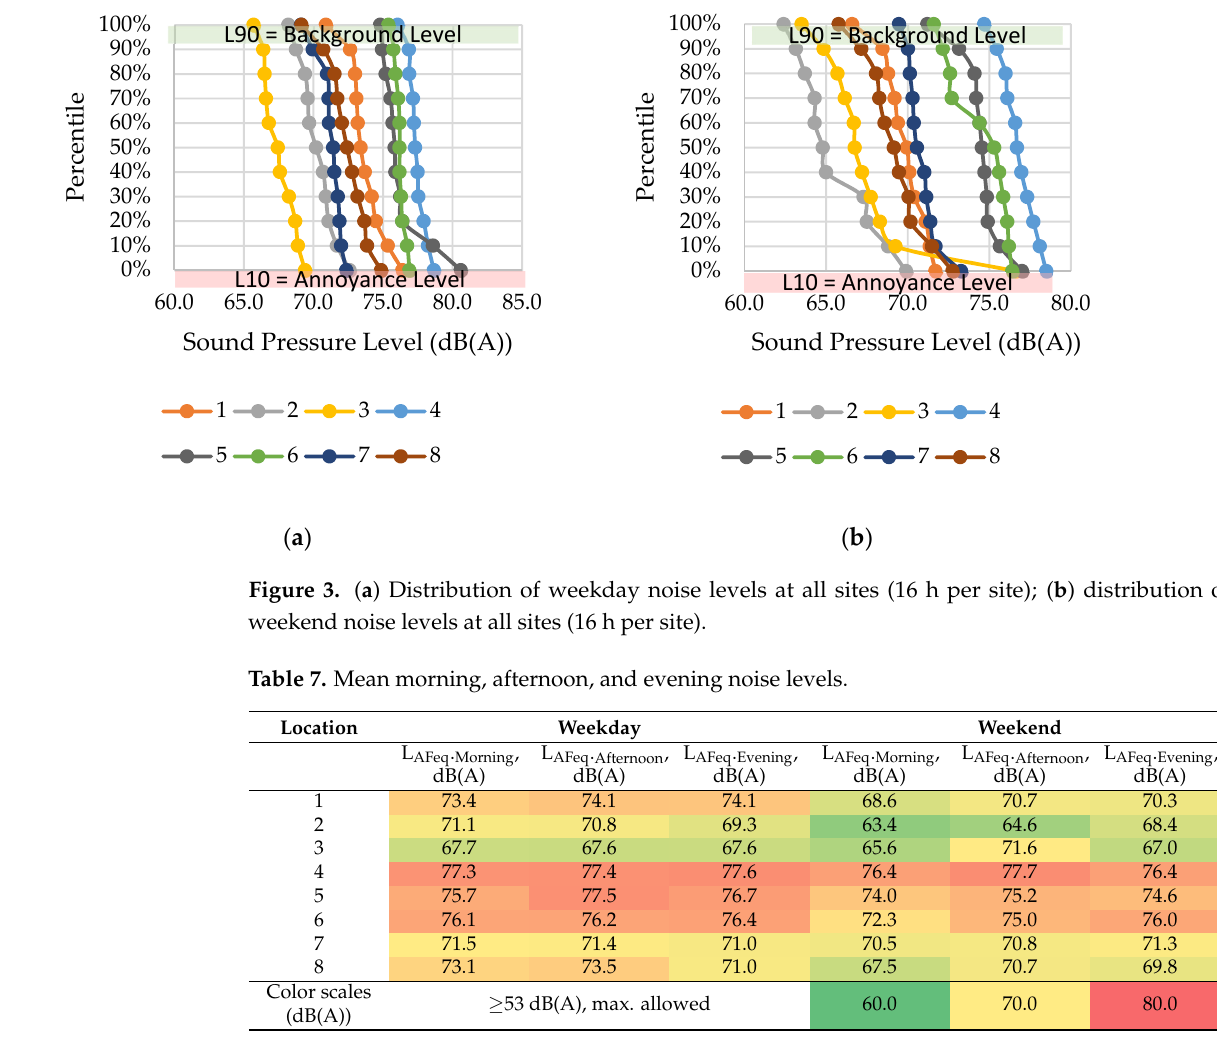
Table 7. Mean morning, afternoon, and evening noise levels.